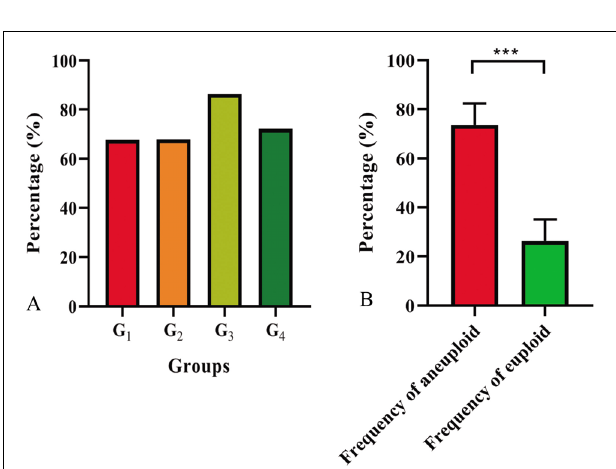
FIGURE 5 | Aneuploid distribution (A) in four groups and frequencies of aneuploids and euploids (B) . P -values labeled with asterisks denote significant difference at *** P <